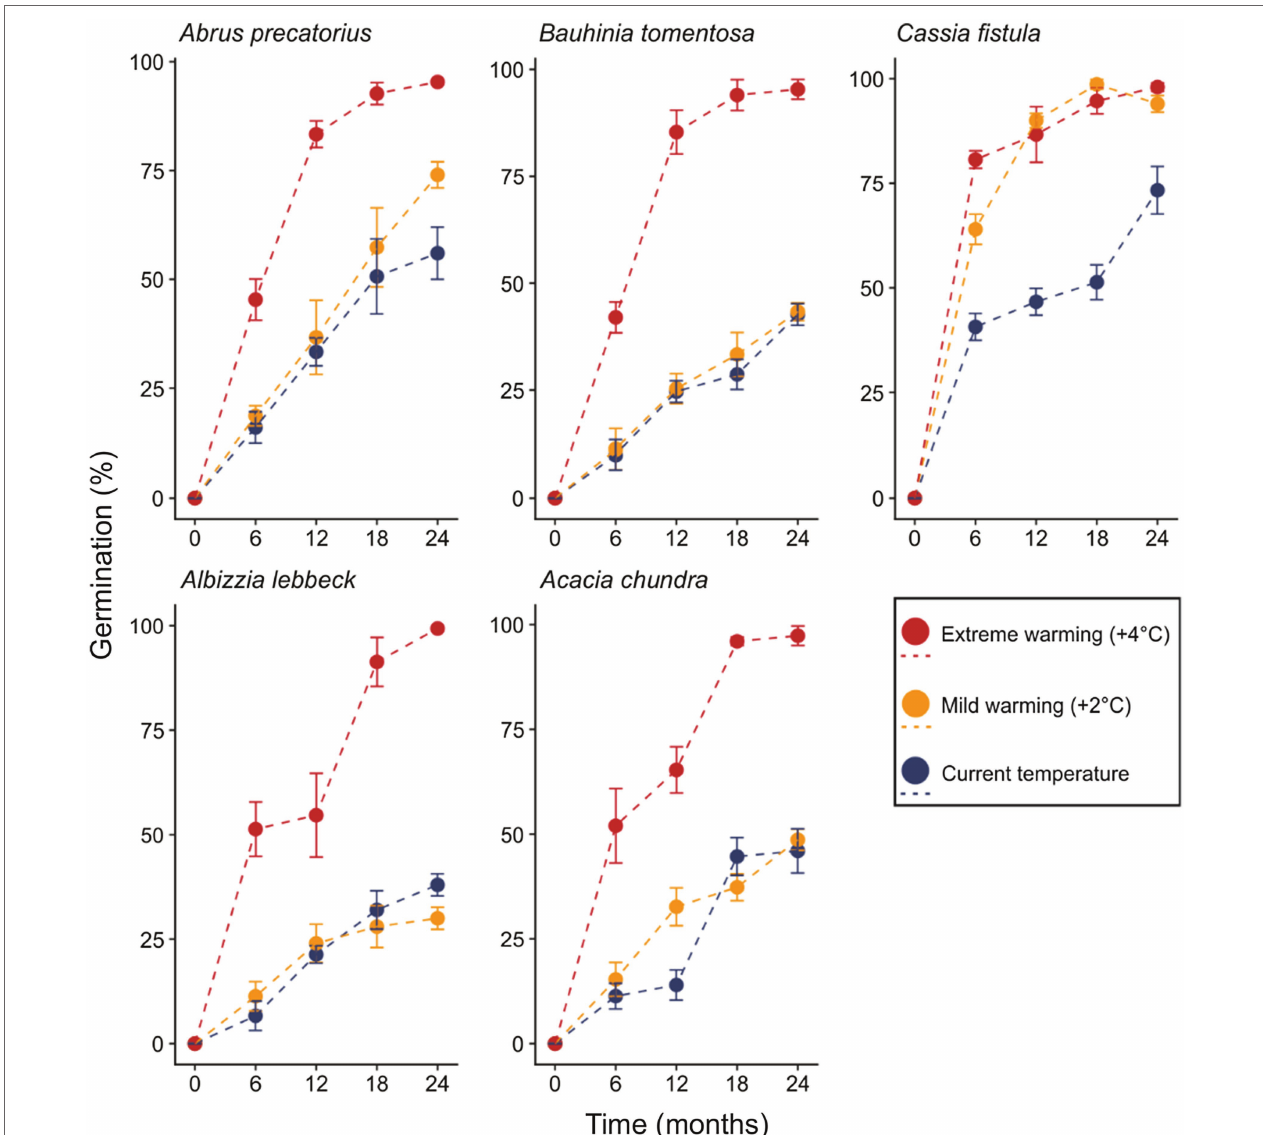
FIGURE 2 | The proportion of seeds germinating over 2 years under control, mild, and extreme warming treatments. Error bars represent the